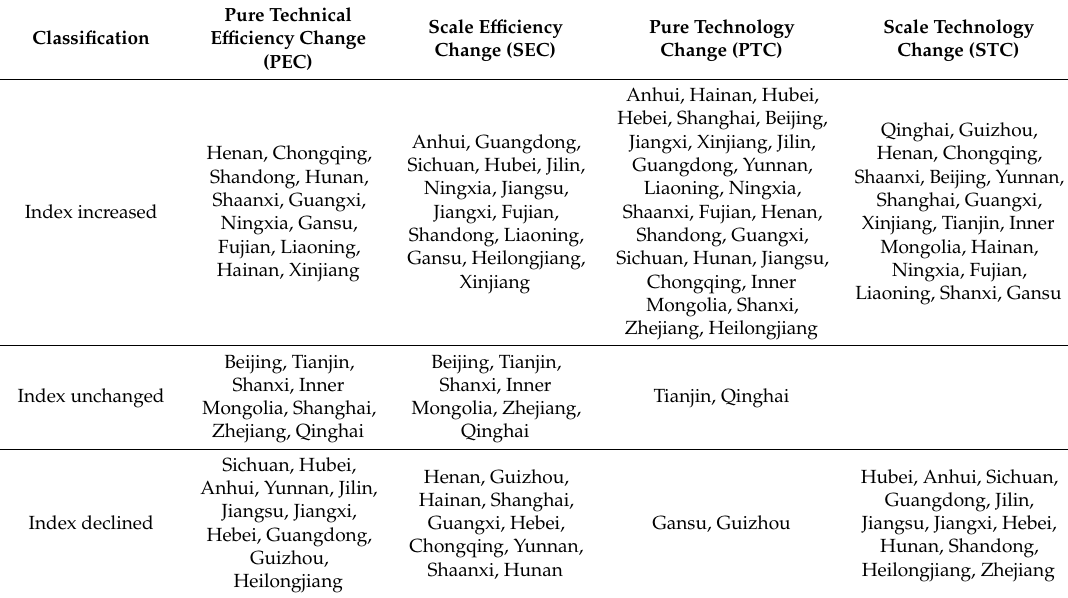
Table 5. GML index decomposition interval division by province during the study period